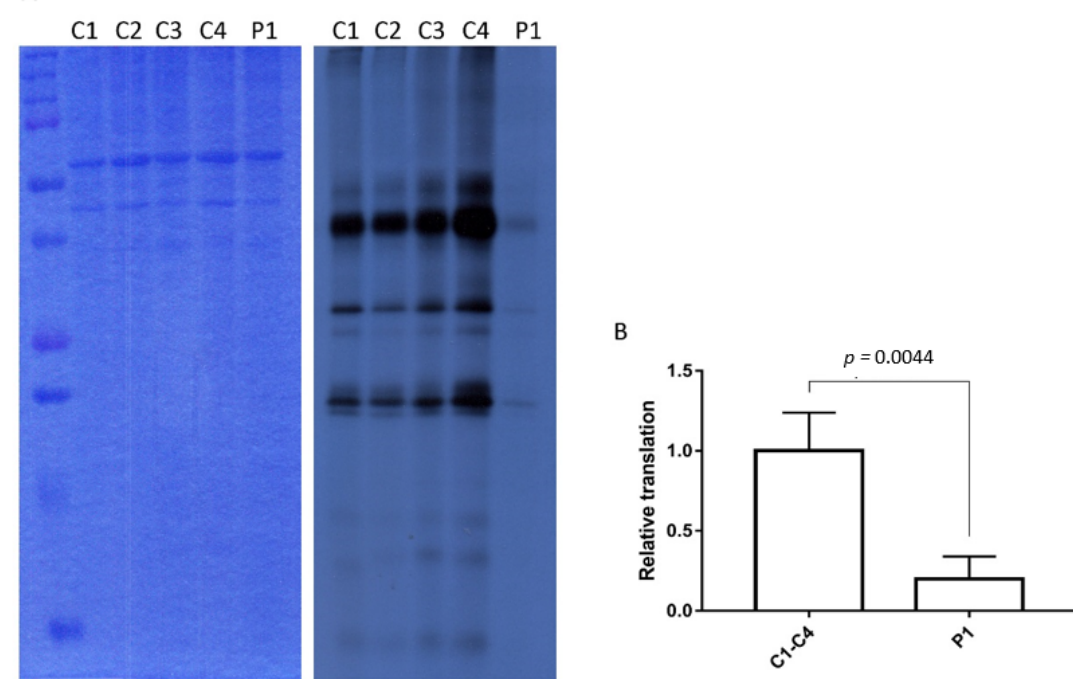
Figure 3. Mitochondrial translation assay. ( A ) Mitochondrial translation assay showing decreased quantity of the proteins synthesized by mitochondrial ribosomes in patient 1 (P1) compared to controls (C1 ‐ C4). Left: Coomassie gel showing the total amount of protein. Right: Exposed autoradiography film showing the mitochondrial bands. ( B ) Quantification of mitochondrial translation. Mitochondrial translation assays were performed in three independent studies in 4 control fibroblast cell lines and in the patient’s fibroblasts. The results show the quantification of mitochondrial translation of the patient fibroblasts with respect to the mean of the control fibroblasts ( n = 4).